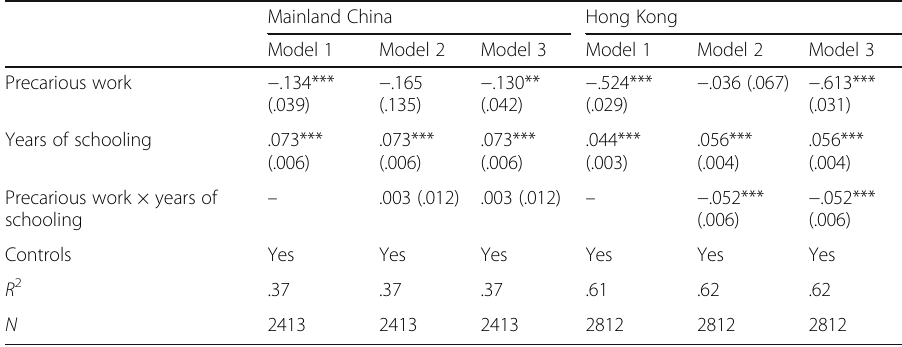
Table 3 Differentials in wages and return on education between precarious workers and non- precarious workers in mainland China and Hong Kong